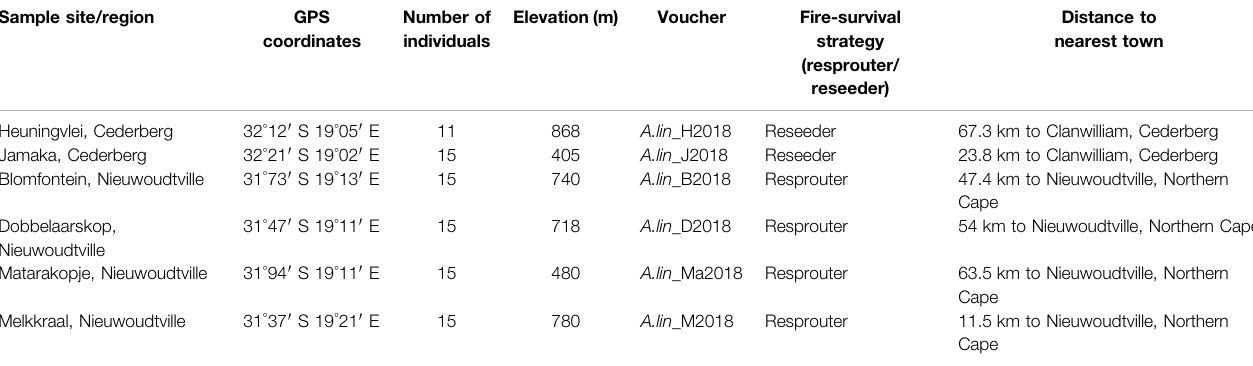
TABLE1| Wildrooibos( Aspalathuslinearis )samplingsitesanddetailsofcollectionsfromtheCederbergregionoftheWesternCapeandtheSuidBokkeveldoftheNorthern